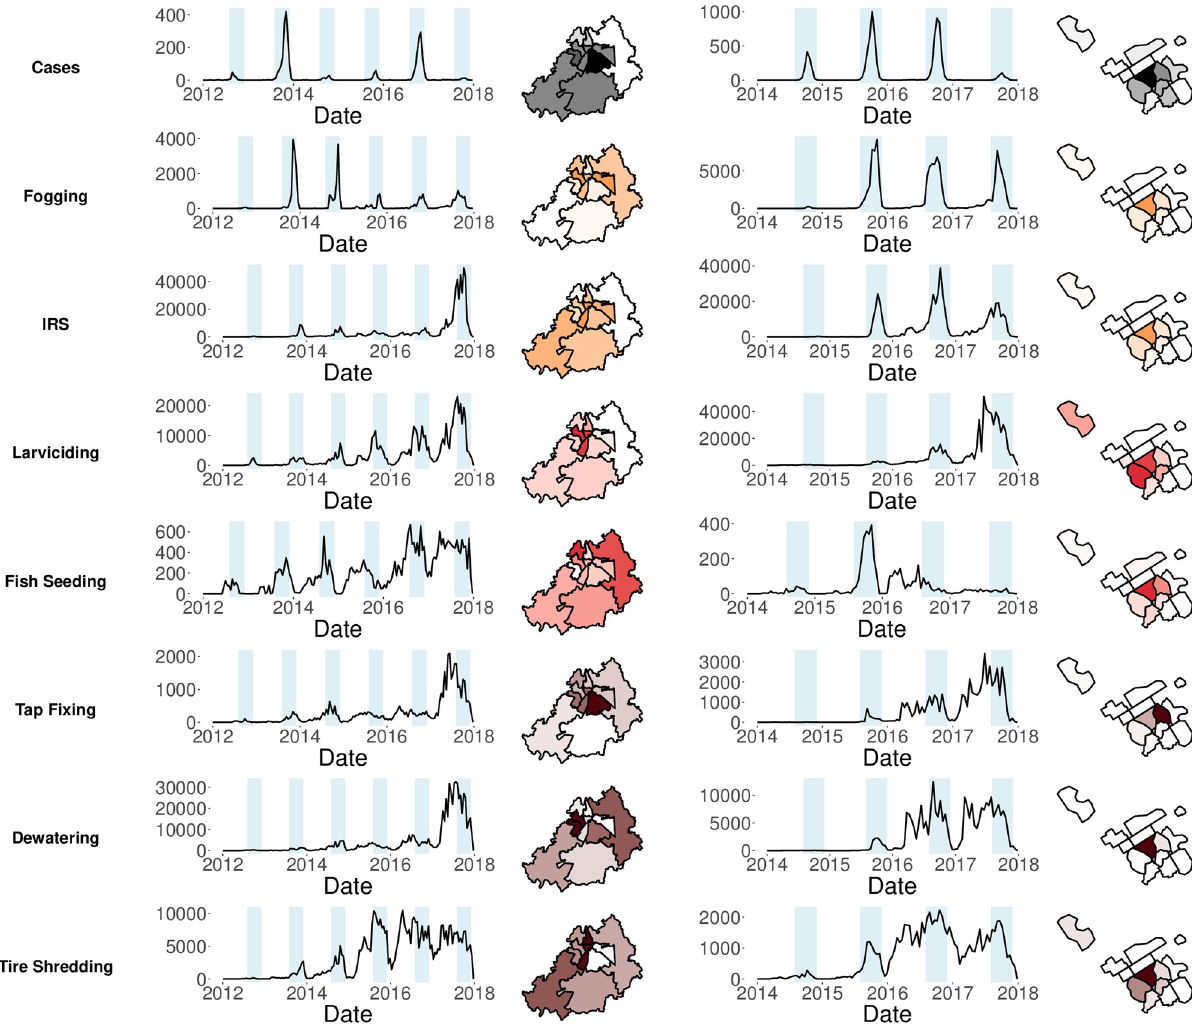
Fig 1. Spatial distribution and timeseries of dengue cases and containment activities. Spatial distribution and bi-weekly aggregate timeseries of dengue cases and containment activities between 2012 and 2017 in Lahore (left), and between 2014 and 2017 in Rawalpindi (right). Timeseries plots for each city show aggregated numbers from all sub-city spatial units. Spatial units colored to show relative distribution of cases and each containment activity within each city; lighter areas with lower numbers (total number of cases and containment activities summarized in Tables A and B in the appendix). Adulticides are color coded orange, larvicides coded red and source reduction activities coded as brown. Spatial units boundaries for each city are shown as black polygons. In Rawalpindi, spatial units are defined only in areas where cases occurred. All figures produced by the